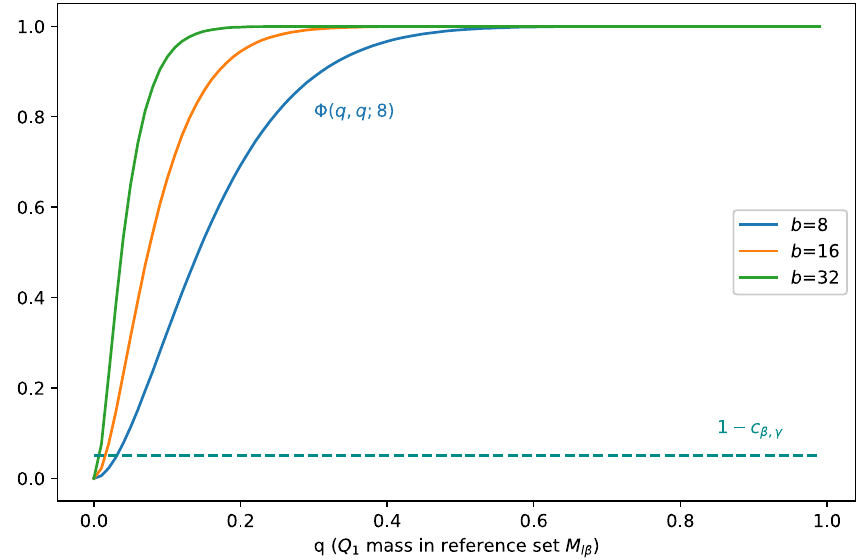
Figure 1. Illustration of when Φ ( q , q ; b ) = 1 − c β , γ holds, i.e., when the mass separation effect starts to occur. When q increases, s should decrease, which means that as M l · β covers more mass of Q 1 , it covers less mass of Q 2 . As the batch size b increases, the least mass of Q 1 that M l · β should cover decreases.